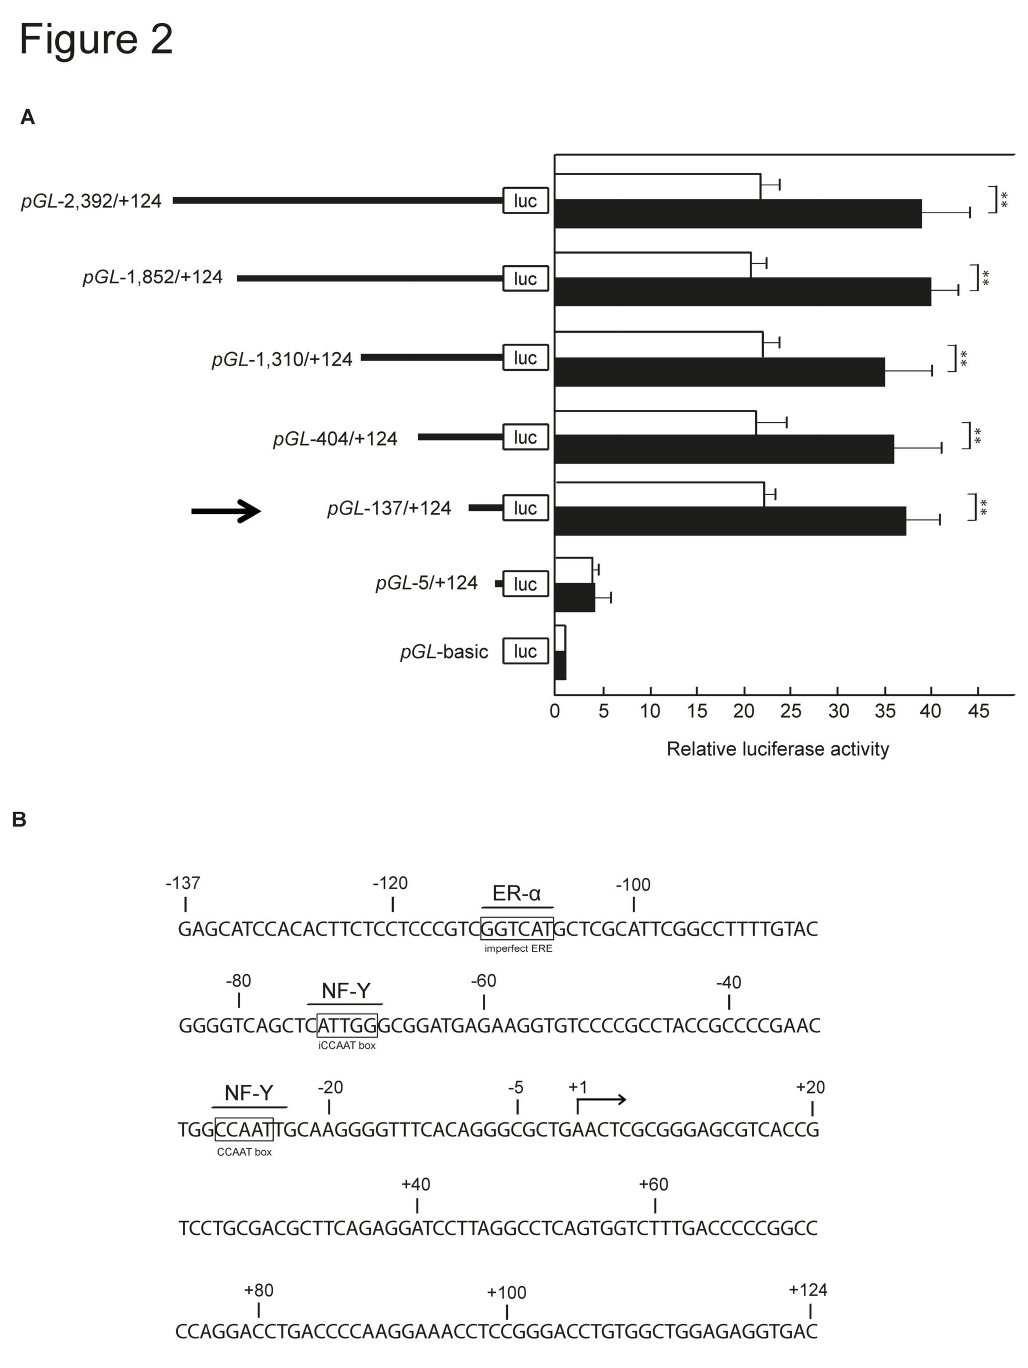
Figure 2. Identification and characterization of the minimal UBC9 promoter. ( A ) MCF-7 cells cultured in phenol red-free medium in the presence (black bars) or absence (white bars) of E were transfected with the indicated constructs and assayed for 2 luciferase activity after 48 hours. The numbers given for each construct indicate the 5’ and 3’ ends of the UBC9 5’-flanking region; the position numbered +1 corresponds to the transcription initiation site. Luciferase activity was expressed as fold change relative to that obtained from promoter-less vector pGL -basic, which was arbitrarily set to 1. Values were normalized for transfection efficiency by co-transfection with the Renilla expression plasmid and were given as mean ±SD obtained in four separate experiments. **P<0.01 (Student’s t -test). ( B ) UBC9 sequence and putative transcription factor binding sites of the minimal UBC9 promoter. Position +1 refers to the transcription initiation site. Putative transcription factor-binding sites predicted by the webtool PromoterSweep [30], including an imperfect ERE, a CCAAT box and an inverted CCAAT box (iCCAAT) are overlined. doi: 10.1371/journal.pone.0075695.g002 PLOS ONE |